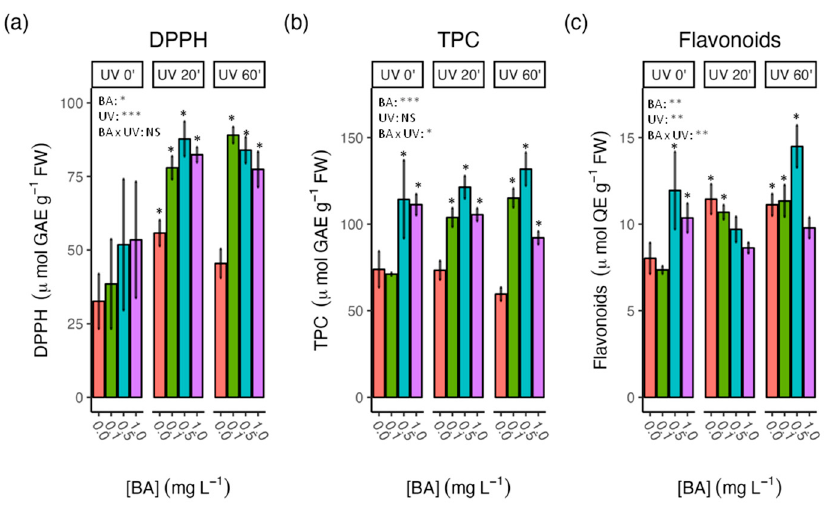
Figure 2. Effect of different concentrations of BA and UV-C treatments on the antioxidant activity and total phenols and flavonoid contents in 6-week-old carob shoots. ( a ) DPPH (1,1-diphenyl-2-picrylhydrazyl radical) activity; ( b ) total soluble phenol content (TPC); ( c ) total soluble flavonoids. Each value represents the mean ± SE. Significant differences from the untreated controls by Tukey’s HSD test at p ≤ 0.05 are indicated with asterisks over the bars. p -values of the two-way ANOVA for the effects of BA dose (BA), UV-C treatment (UV) and their interaction (BA × UV) are indicated by asterisks: *, p ≤ 0.05; **, p ≤ 0.01; ***, p ≤ 0.001; NS, not significant.